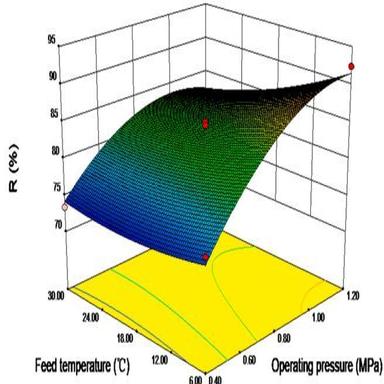
Response surface plot of the rejection to total soluble salts vs. the operating pressure and feed temperature.